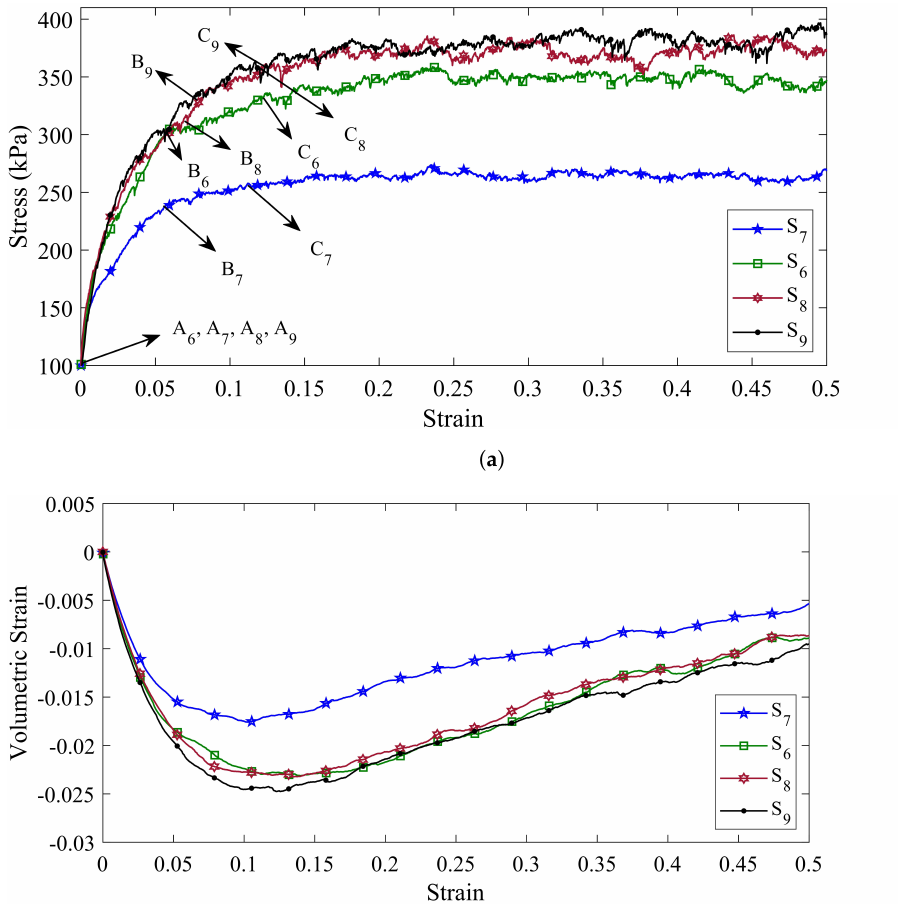
Figure 7. ( a ) The shear stress behavior, and ( b ) the volumetric strain behavior of the specimens with different rolling friction coefficient ( η r ) (The rolling friction coefficients for specimens S 6 , S 7 , S 8 , and S 9 are equal to 0.5, 0.1, 1, and 1.25,